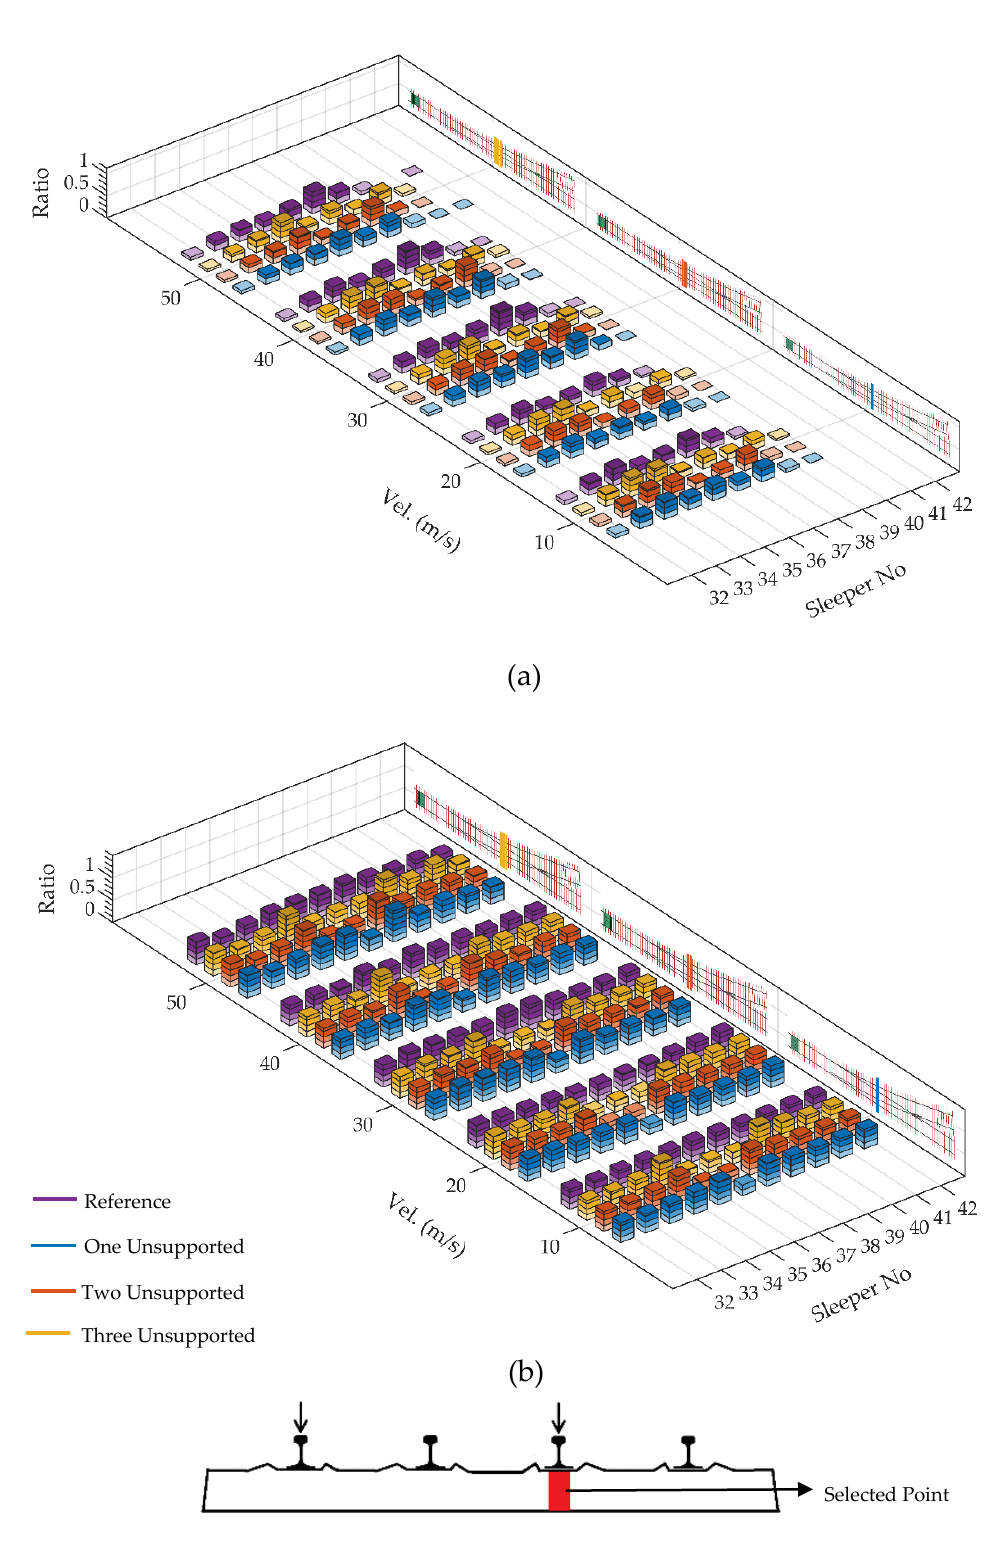
Figure 12. The distribution of rail seat force over the bearers when unsupported bearers exist at closure panel: (a) at particular time when the front wheel is on the bearer with number 37; (b) when maximum occurs at each bearer.